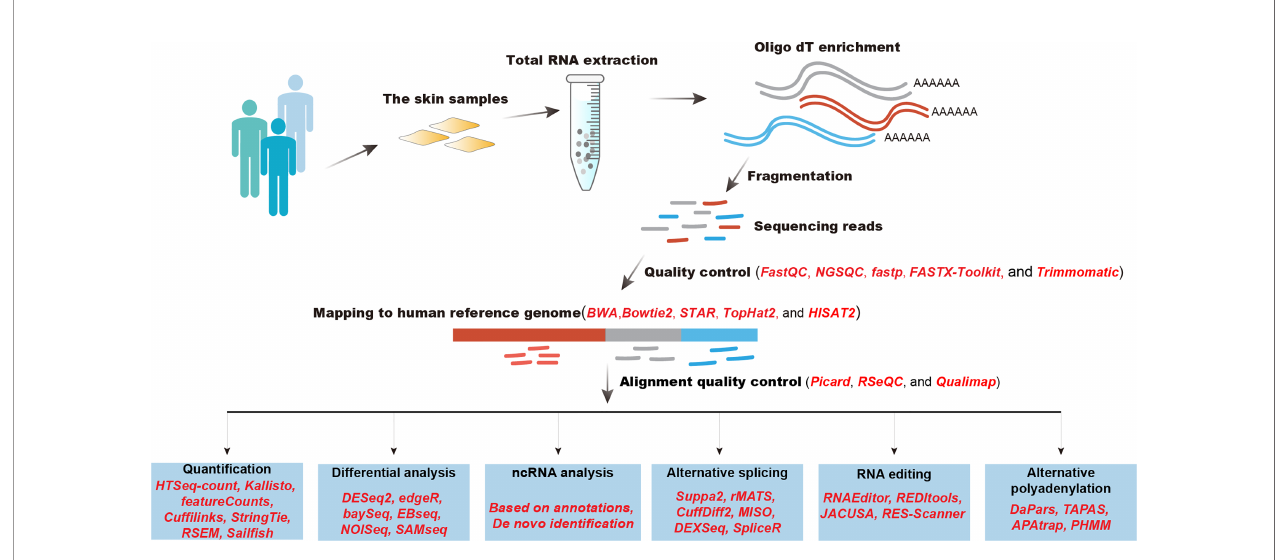
FIGURE 1 | A best practice of RNA-seq data analysis of in fl ammatory